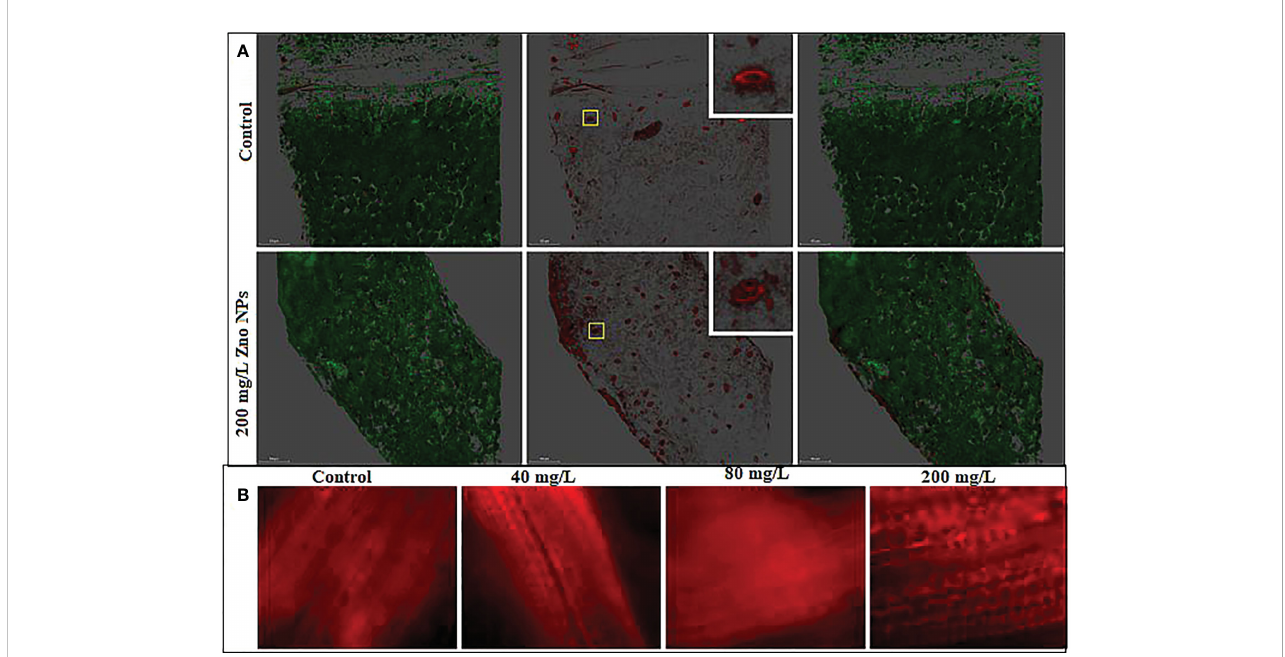
FIGURE 10 Increase in reactive oxygen species (superoxide) in mustard leaves treated with ZnO NPs and stained with Mitosox. (A) Confocal images of the structure of chloroplast and stomata. The boxed region represents the magni fi ed region. (B) Bright fi eld fl uorescent images of the leaf veins. The intensity of the dye represents the high accumulation of superoxide in the leaf